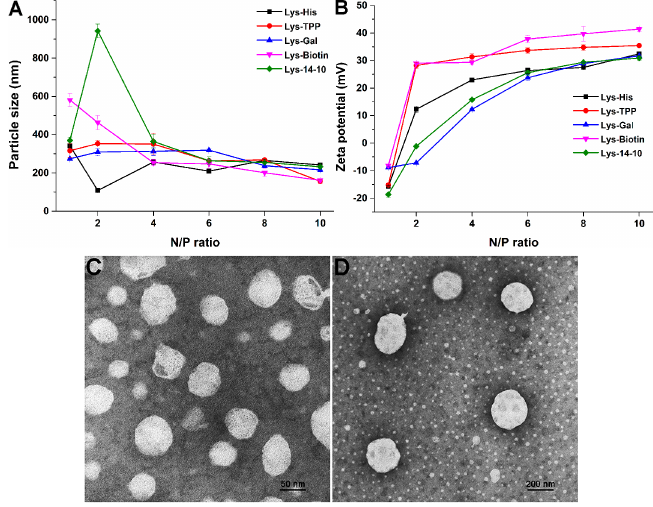
Figure 2. Characterization of the bolaplexes. ( A ) Mean particle sizes; ( B ) zeta-potentials. Data represent mean ± SD ( n = 3). ( C , D ) TEM images of bolasome and bolaplex (N/P = 4) formed from Lys-His.